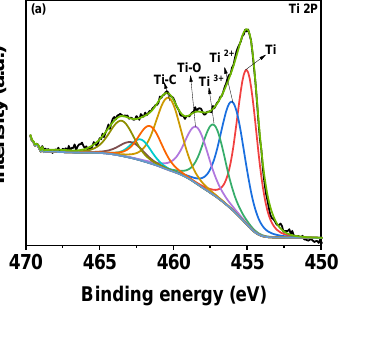
Figure 3. XPS high-resolution peak profiling of ( a – c ) Ti 2þ, Ni 2þ and O1s of MX − Ni composites. The MX − Ni electrode was later characterized for its improved electrochemical kinetics using the EIS technique. Figure 4a shows the corresponding Nyquist plot of MX − Ni in reference to pristine Ti 3 C 2 T x and Ni NPs. Here, Ti 3 C 2 T x exhibited the smallest charge-transfer resistance (smallest semi-circle) compared to MX − Ni NPs, demonstrating a lower resistance than pristine Ni NPs. This confirmed that MX − Ni composites had adopted the conductive characteristics of both MXene and Ni NPs, and faster interfacial-charge trans- fer could be anticipated during the redox process. Figure 4b shows the response of the MX-Ni modified electrode against 0.5 mM of K 4 [Fe (CN) 6 ]/K 3 [Fe (CN) 6 ] in 0.1 M KCl as a